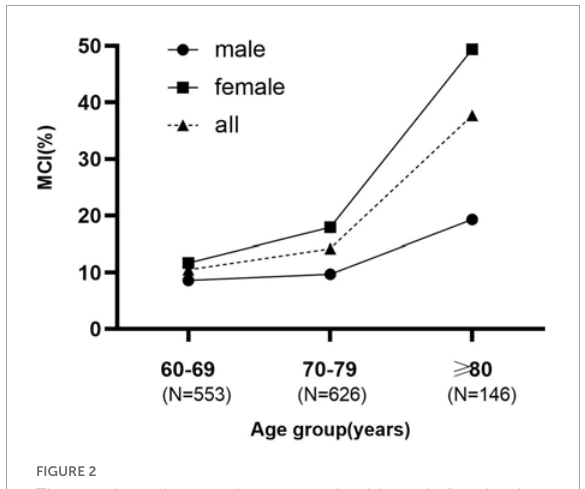
FIGURE2 The prevalence increased more steeply with age in females than males.